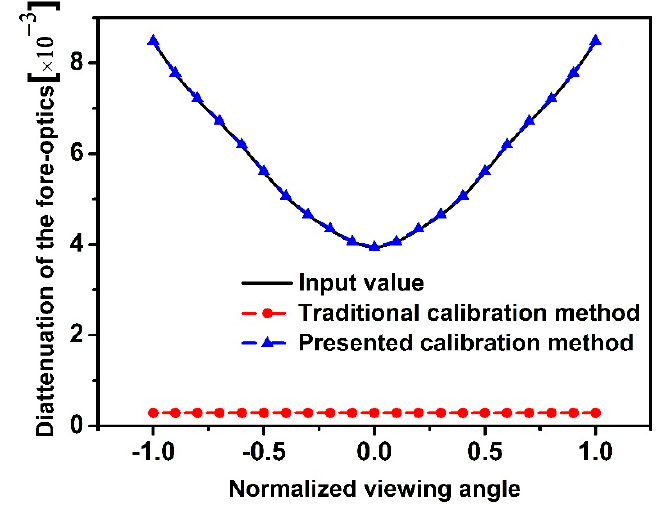
Figure 5. Magnitude of the autocorrelation function of A k (cid:48) ( σ ,1 )